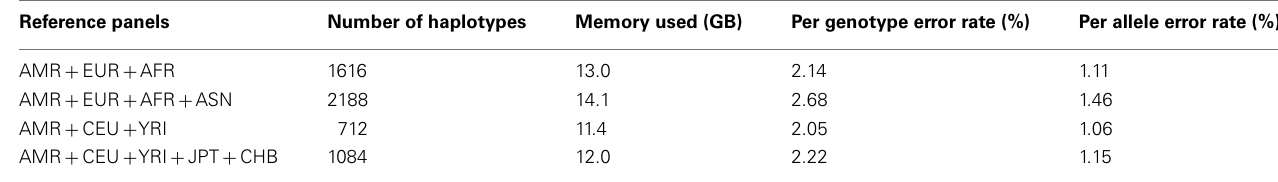
TableA2 | Genotype imputation accuracy for chromosome 13 based on the 1000 Genomes Project reference panels. Reference panels